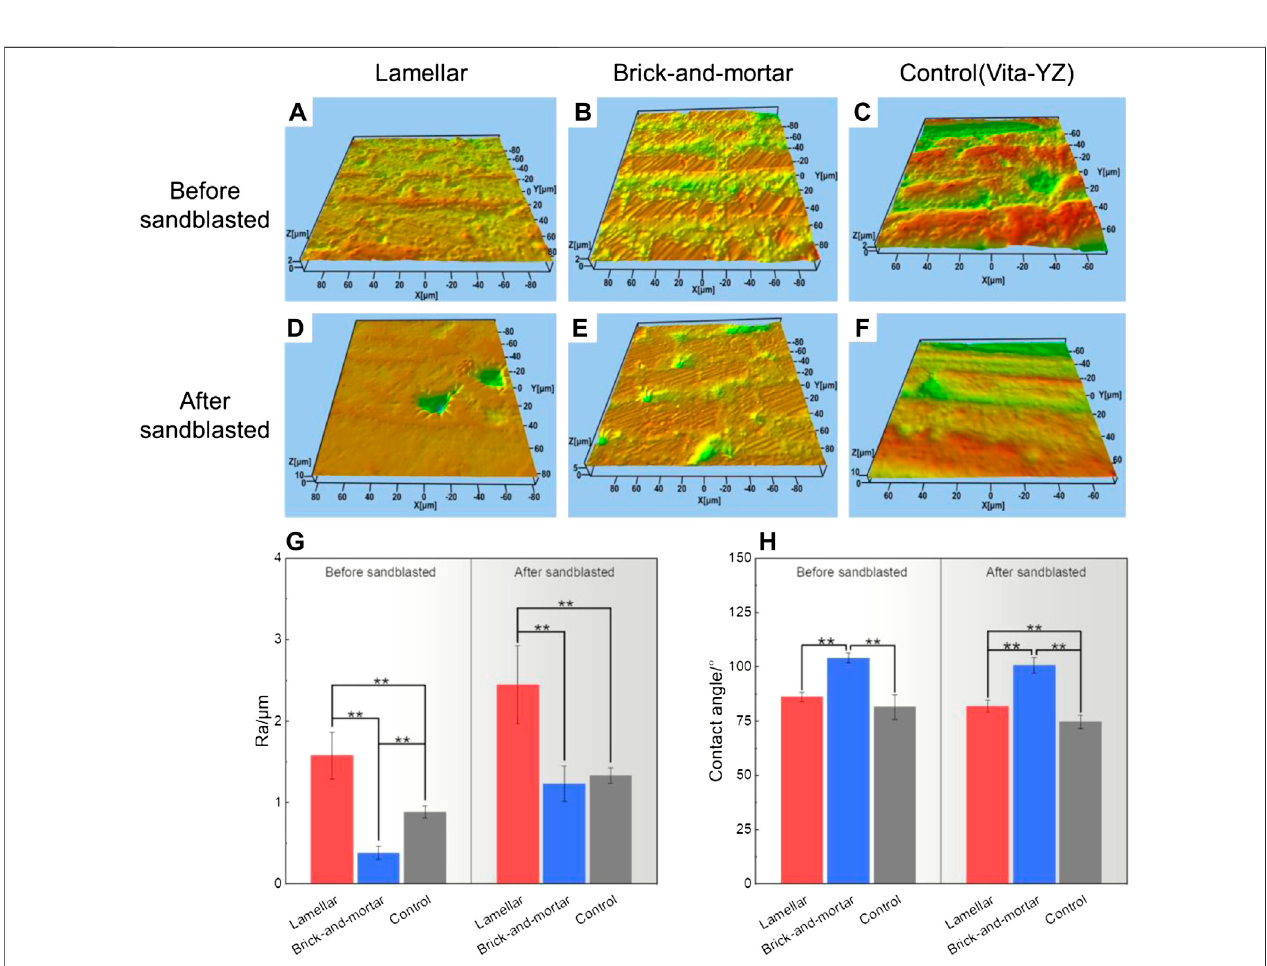
FIGURE 4 | Surface three-dimensional morphology (A – F) , surface roughness (G) and contact angle (H) of all groups.